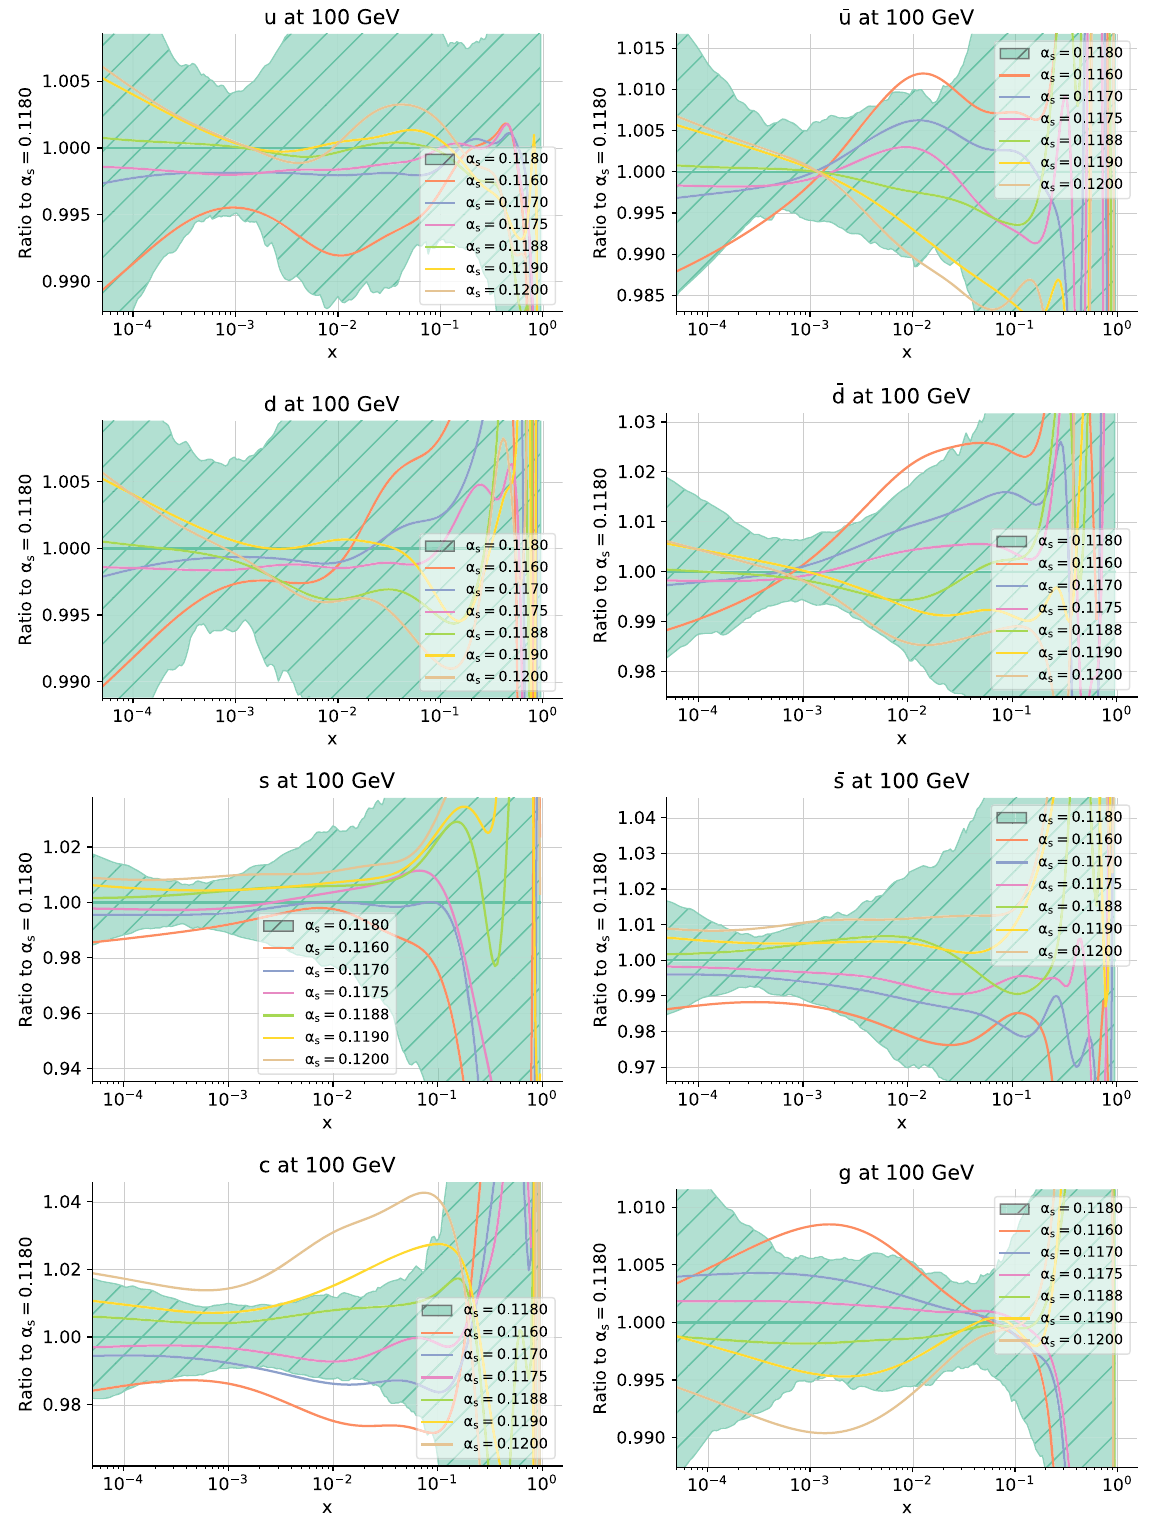
Fig. 20 Same as Fig. 17, now comparing PDFs obtained using different values of α s ( m Z ) = 0 . 116 , 0 . 117 , 0 . 1175 , 0 . 118 , 0 . 1185 , 0 . 119 , 0 . 120, normalized to the α s ( m Z ) = 0 . 118 baseline, with only the central value shown for other